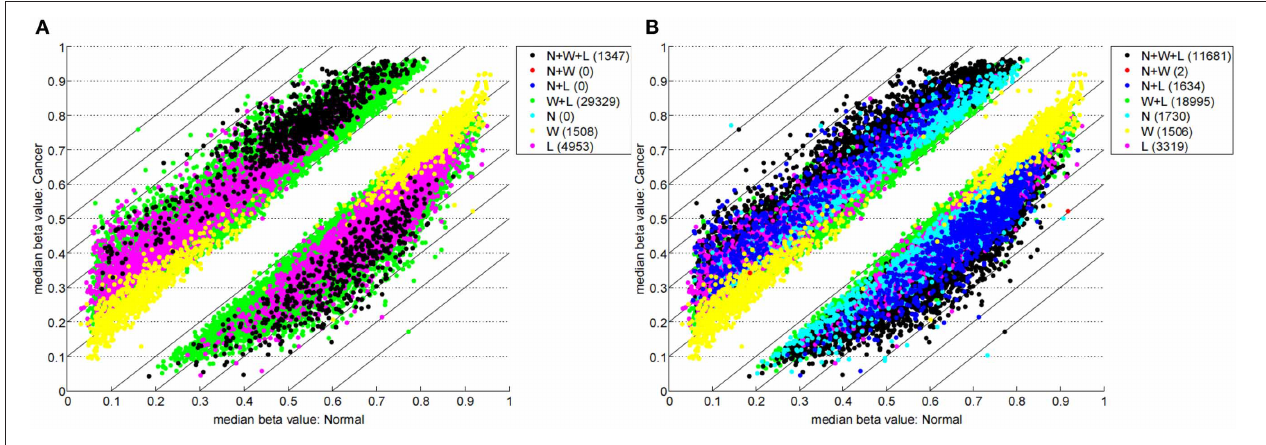
FIGURE 2 | Comparison of methylation levels without post-filter. NIMBL-compare output of median beta values of normal versus cancer samples when no samples ( m = 0) (A) or up to two samples ( m = 2)